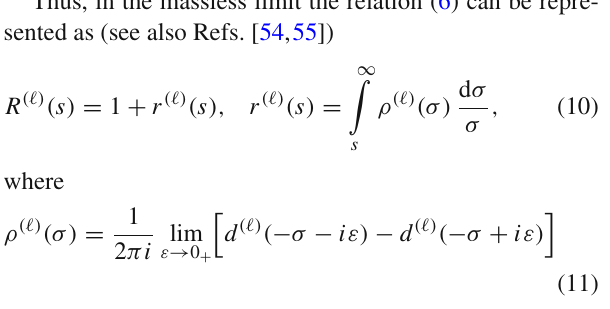
Fig. 2 The one-loop spectral function ¯ ρ ( 1 ) ρ(σ) (11), which enters the pertinent integral